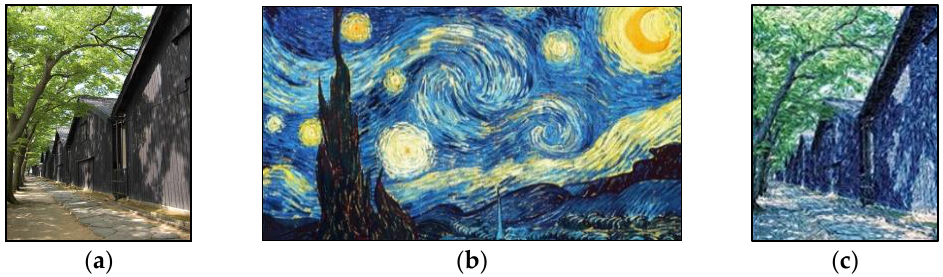
Figure 13. ( a ) Landscape, ( b ) Van Gogh, “Starry Night”, ( c ) Stylized image.